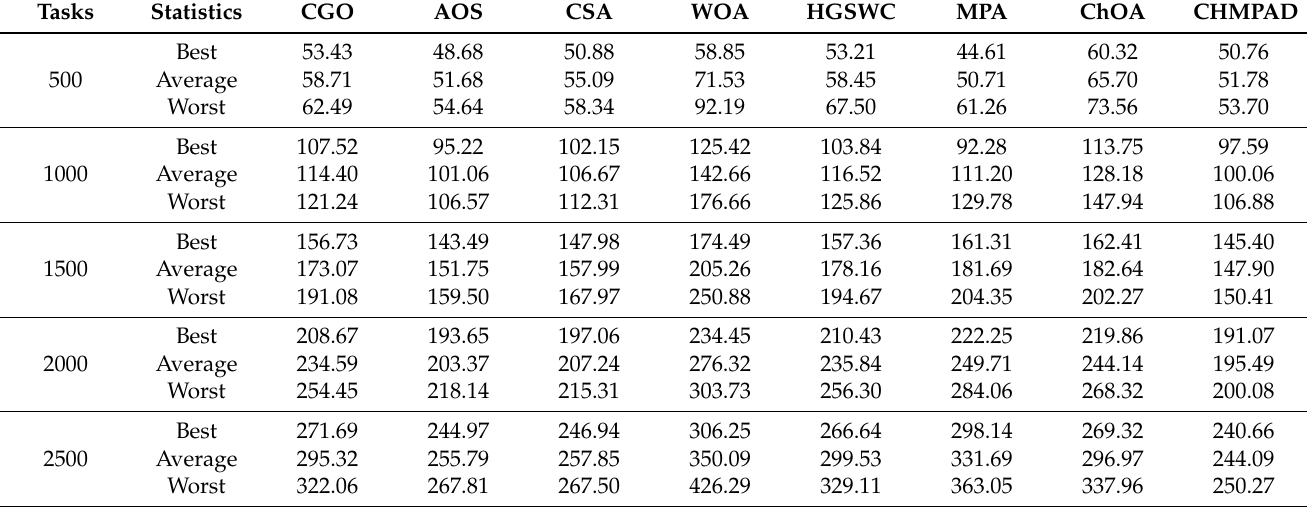
Table 4. Makespan values of CHMPAD algorithm and compared algorithms—NASA iPSC